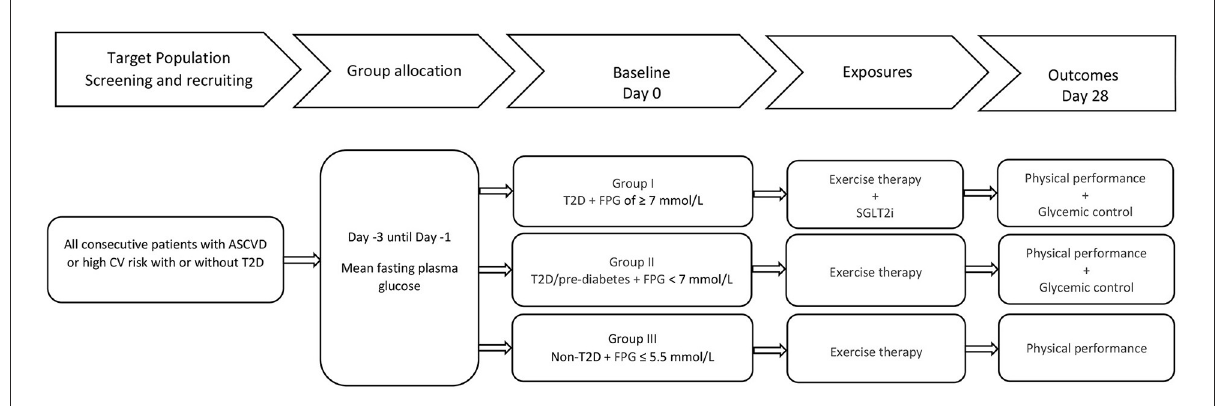
FIGURE1 Flowchart of the PUSH study. ASCVD, atherosclerotic cardiovascular diseases; CV, cardiovascular; T2D, type II diabetes mellitus; FPG, fasting plasma glucose; SGLT2i, sodium glucose cotransporter 2